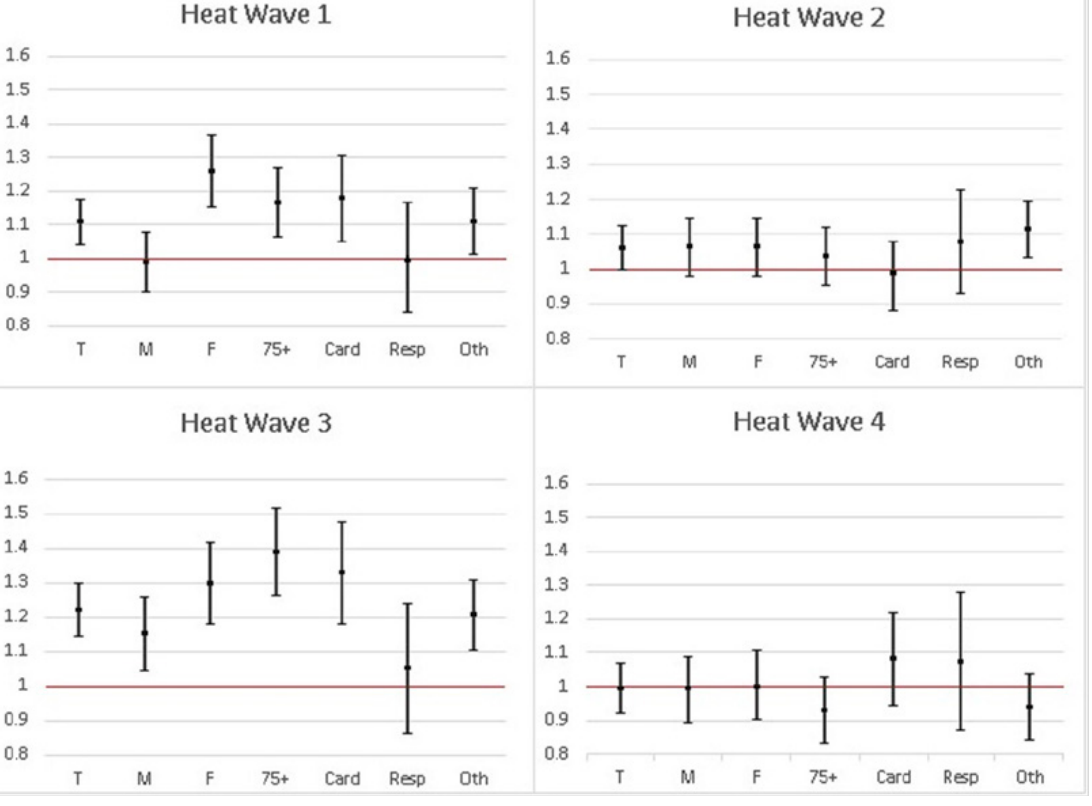
Figure 2. The crude death rates and CI 95% of the Extreme Heat Waves between 2013 and 2017 (27 Jul–2 Aug 2015, 5 Aug–14 Aug 2016, 29 Jun–4 Jul 2017, 5 Aug–10 Aug 2017 respectively) by categories. (T: Total, M: Male, F: Female, 75 + : 75 years old and above, Card: cardiovascular diseases, Resp: Respiratory diseases, Oth: